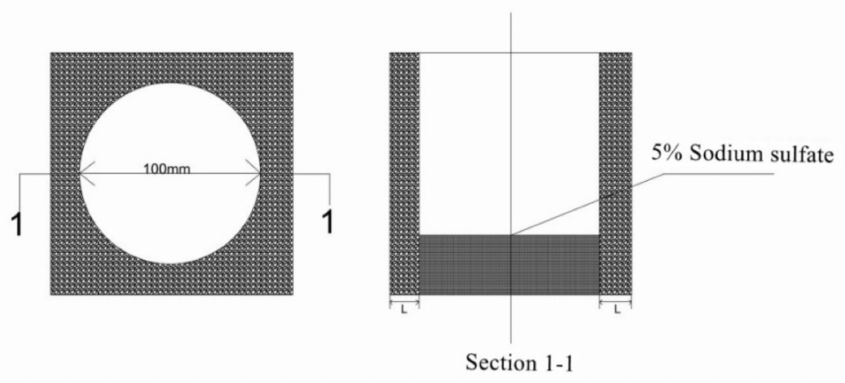
Figure 4. Schematic diagram of crystallization